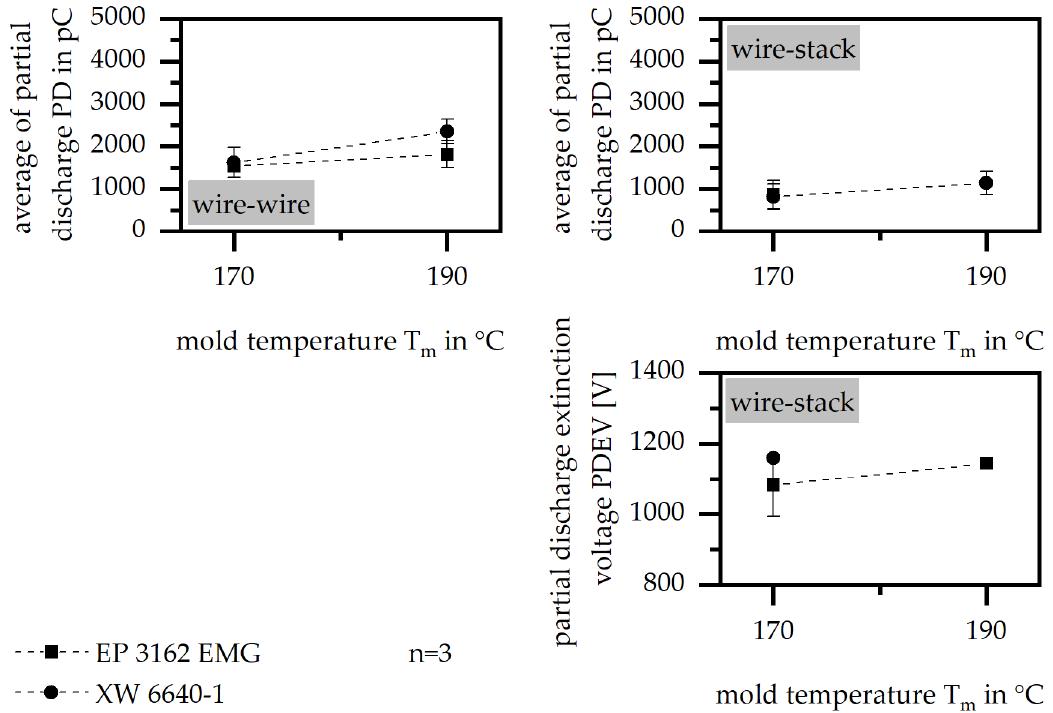
Figure 5. Average of partial discharge (PD) and partial discharge extinction voltage (PDEV) relative to the mold temperature in the insulation system of wire to wire and wire to stack.